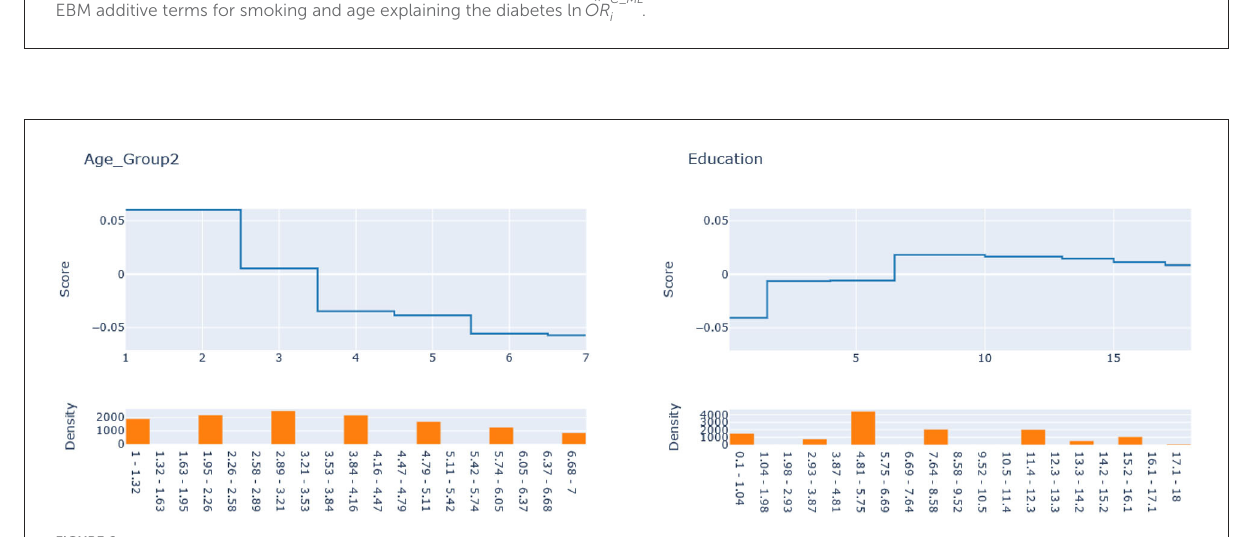
FIGURE5 EBM additive terms for smoking and age explaining the diabetes ln ˆ OR